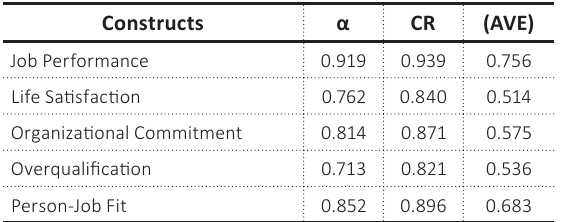
Table 1. Construct reliability and